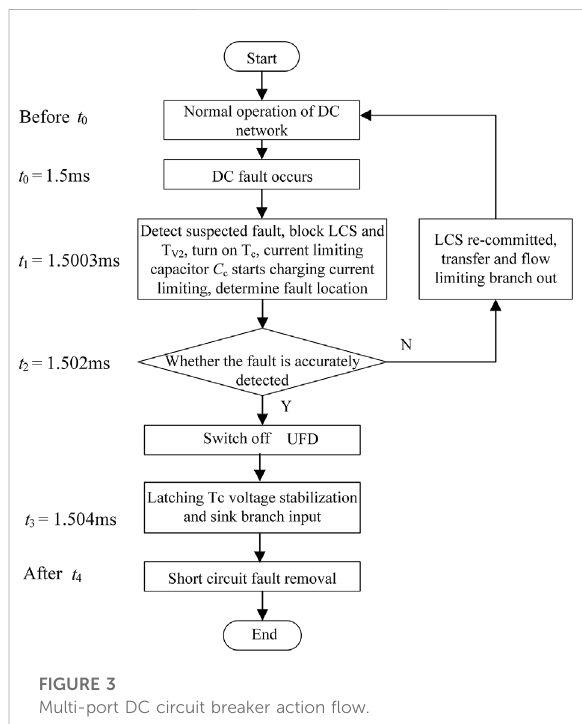
FIGURE 3 Multi-port DC circuit breaker action fl